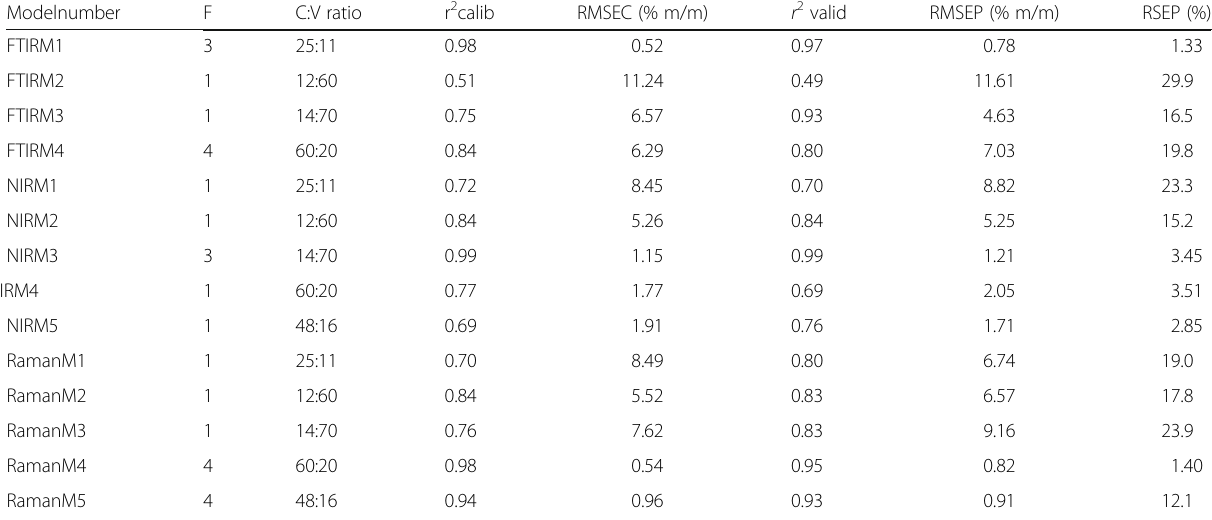
Table 3 Results of the PLSR models constructed using the three techniques